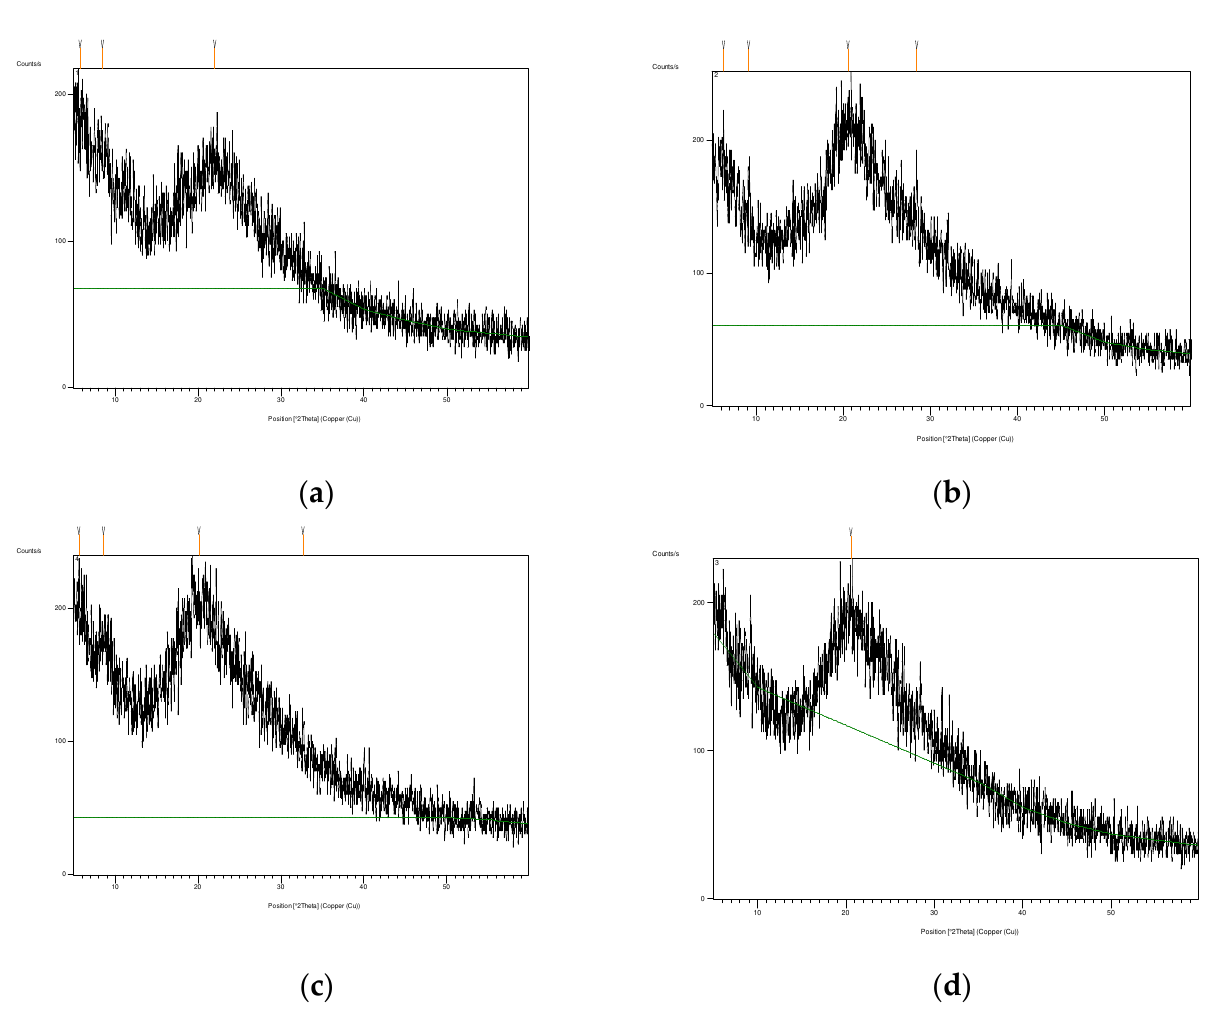
Figure 4. X-ray Diffraction patterns of tested films: ( a ) Chitosan; ( b ) Chitosan + 0.1% GEO; ( c ) Chi- tosan + 0.2% GEO; ( d ) Chitosan + 0.3%